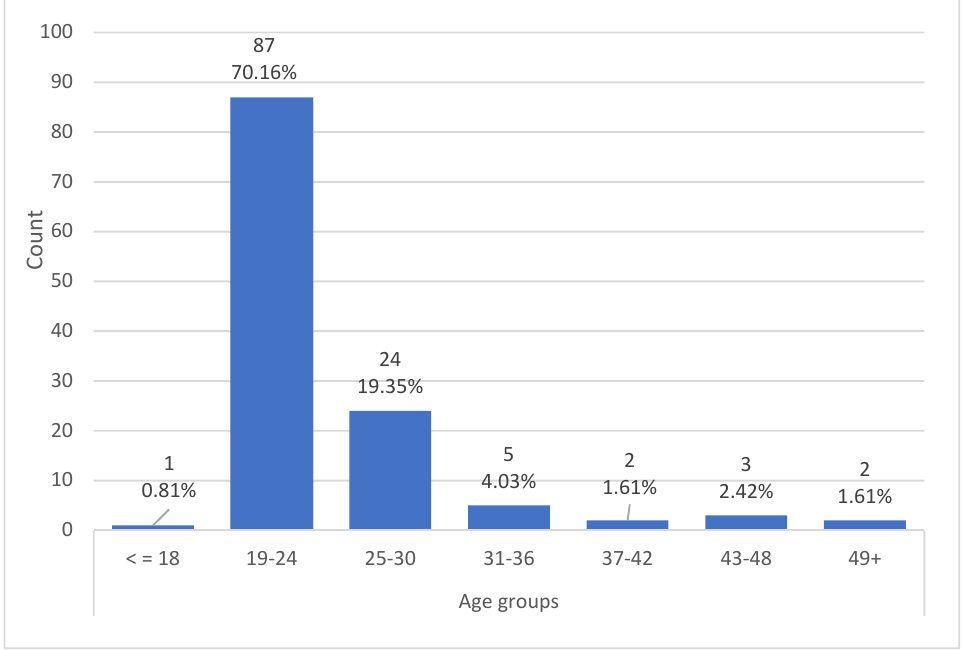
Table 3. Construct reliability.